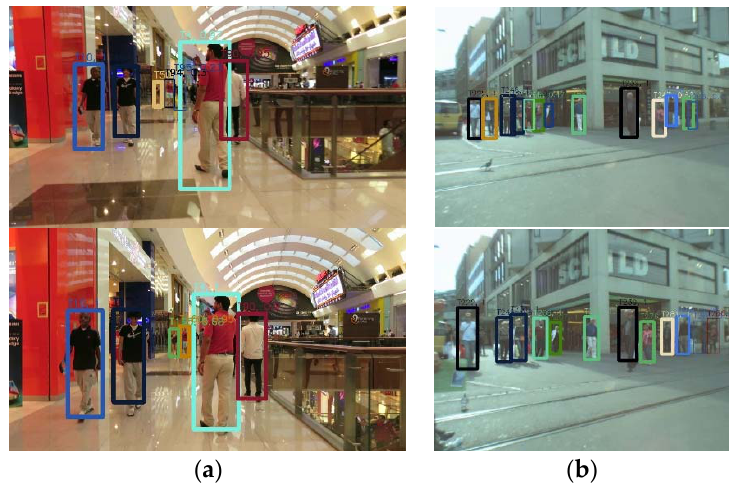
Figure 1. Some tracking results with the proposed method. ( a ) Tracking results of the 23rd frame and 49th frame of MOT16 ‐ 11. ( b ) Tracking results of 78th frame and 94th frame of ETH ‐ Linthescher.